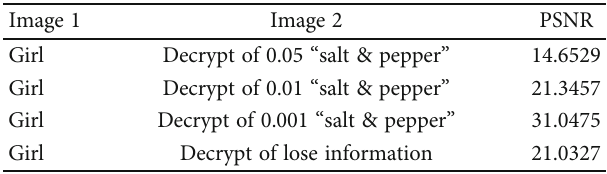
Figure 12: Robustness analysis. (a) 0.05 “ salt & pepper. ” (b) 0.01 “ salt & pepper. ” (c) 0.001 “ salt & pepper. ” (d) Lose information. (e) Decrypt of 0.05 “ salt & pepper. ” (f) Decrypt of 0.01 “ salt & pepper. ” (g) Decrypt of 0.001 “ salt & pepper. ” (h) Decrypt of lose information. Table 10: PSNR of robustness analysis.